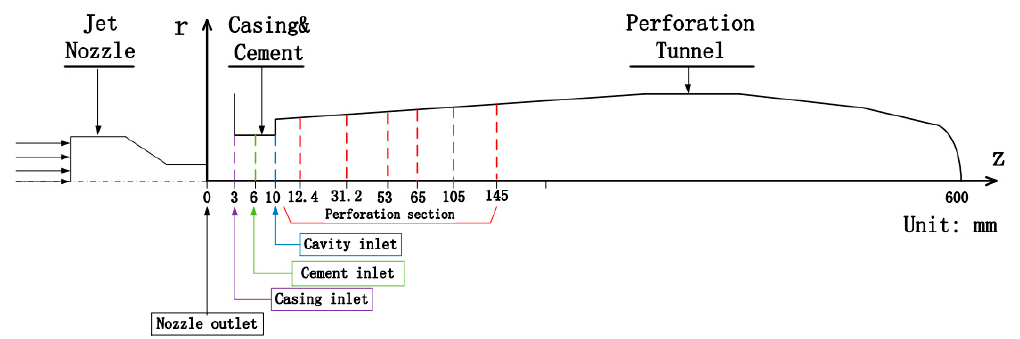
Figure 9. Schematic representation of the vertical section of the simulation.